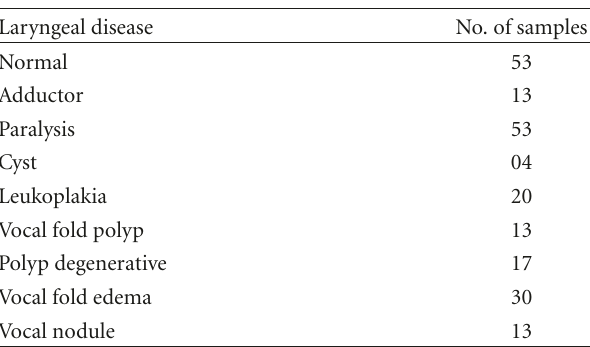
Table 1: Details of the voice signals used in the